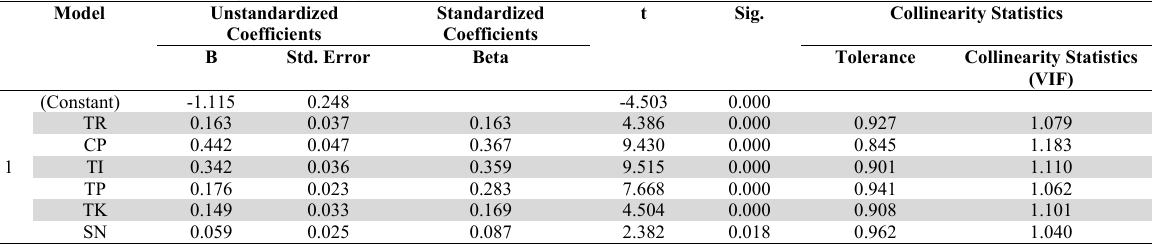
Source: Research